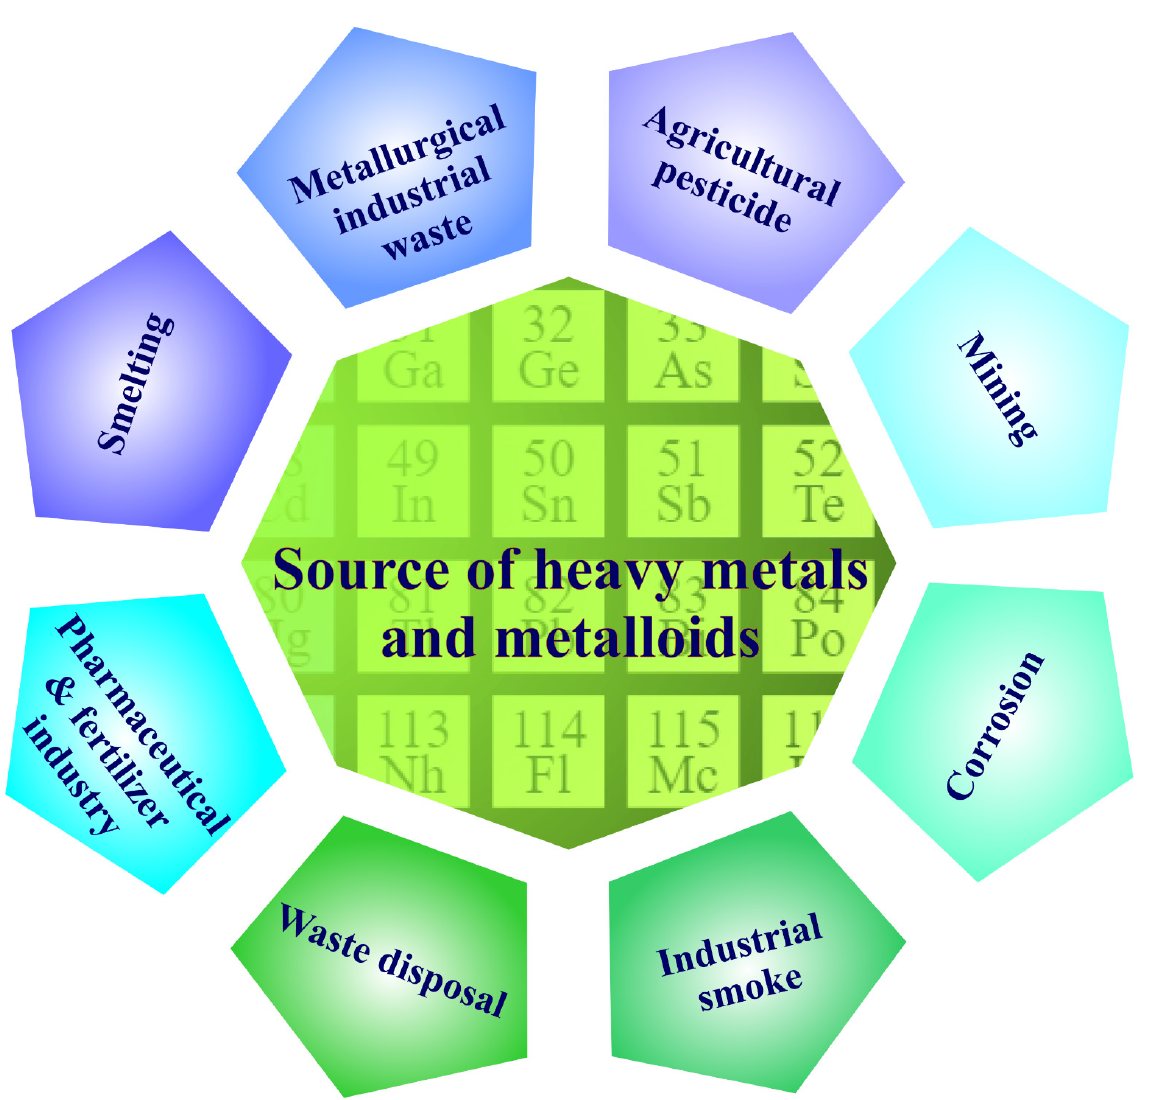
Figure 1. Main sources of heavy-metal and metalloid